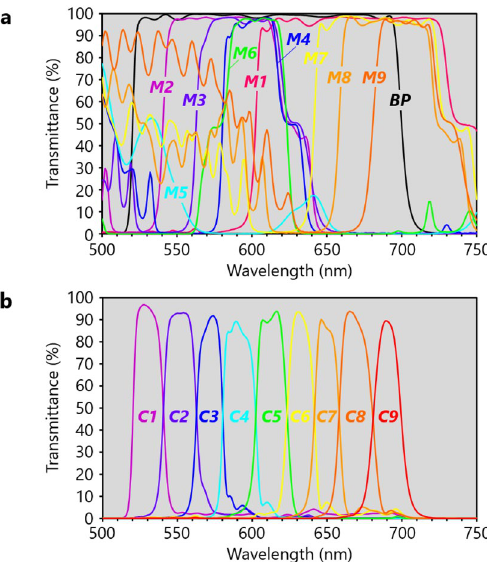
Figure 4. Transmission spectra of dichroic mirrors and split nine-color fluxes. ( a ) Measured transmission spectra of M1 − M9 at incident angles of 45° and BP at incident angle of 0°. ( b ) Transmission spectra of C1 – C9 relative to C0 calculated from ( a